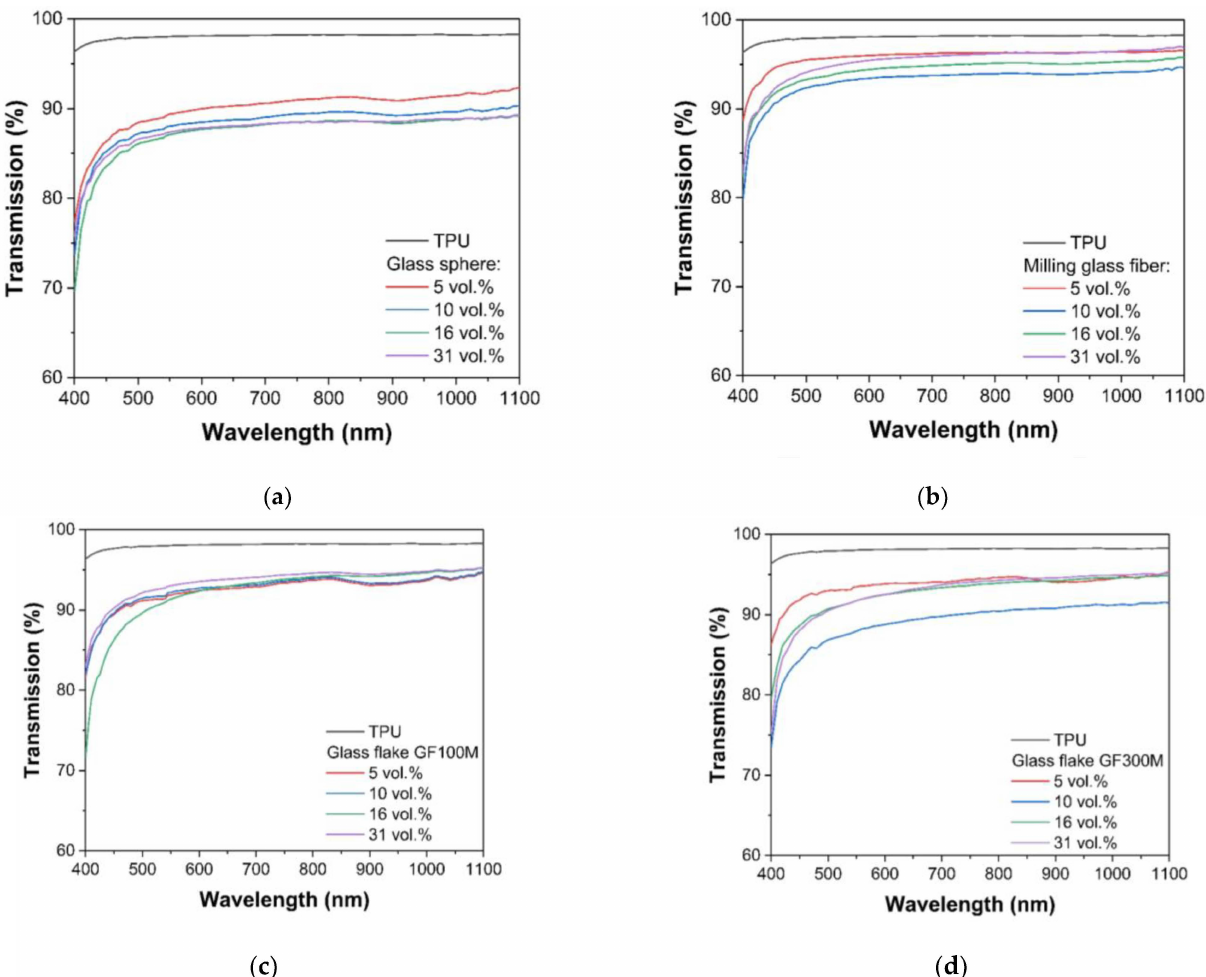
Figure 7. Transmission spectra of composite filling by glass sphere ( a ), milling glass fiber ( b ), glass flake GF100M ( c ) and GF300M ( d